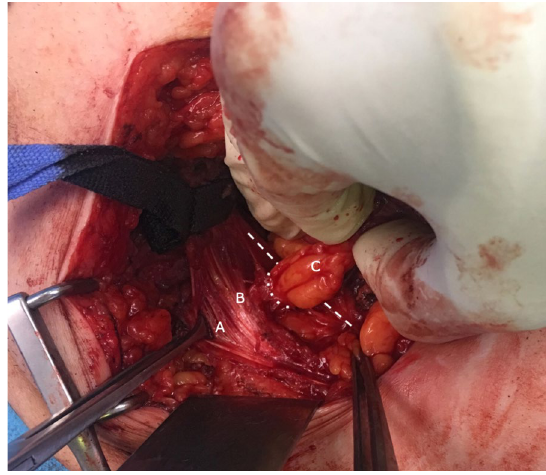
Fig. 2 Craniocaudal view of the left inguinal canal and femoral space. A Incised external oblique muscle. B Inguinal ligament. C Greater omentum removed from the femoral canal. The dotted lines indicate the limits of the femoral ring. The colored lines indicate Cooper’s